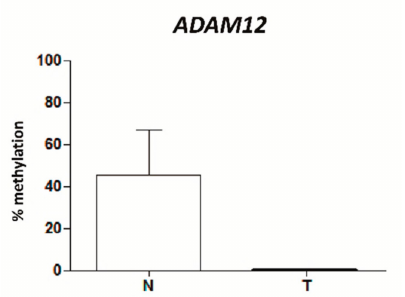
Figure 7. Percentage methylation of the mean of all the analysed CpGs in the ADAM12 gene in TNBC was measured by pyrosequencing in non-neoplastic breast (N) and TNBC (T) total circulating cell-free DNA (cfDNA) from